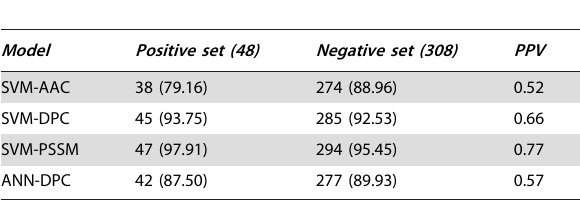
Table 3. Performance on benchmark datasets.